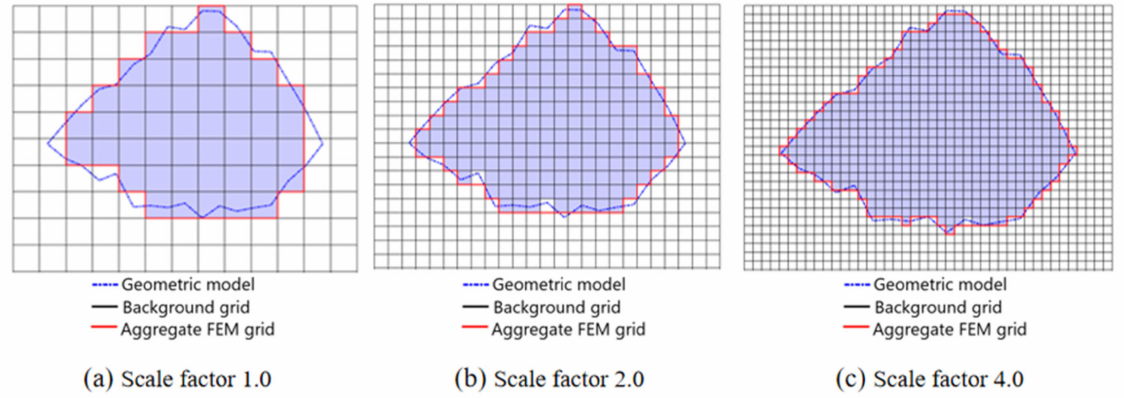
Figure 4. Diagram of grid mapping, ( a ) scale factor 1.0; ( b ) scale factor 2.0; ( c ) scale factor 4.0.